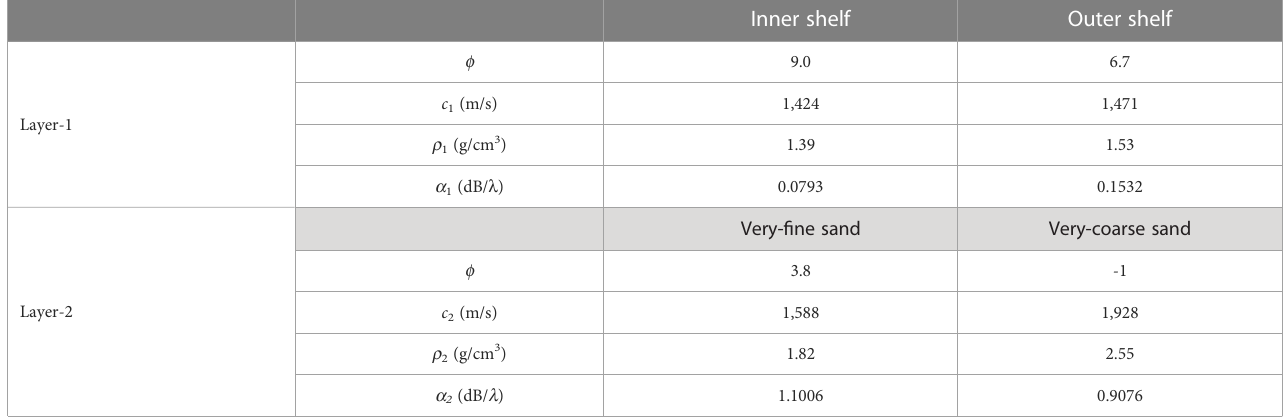
TABLE 1 Mean grain size ( f ), sound speeds ( c ), densities ( p ) and attenuations ( a ) applied in the two-layer bottom structure